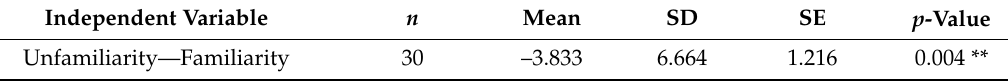
Table 17. Paired t -test results for the number of web page surfed.